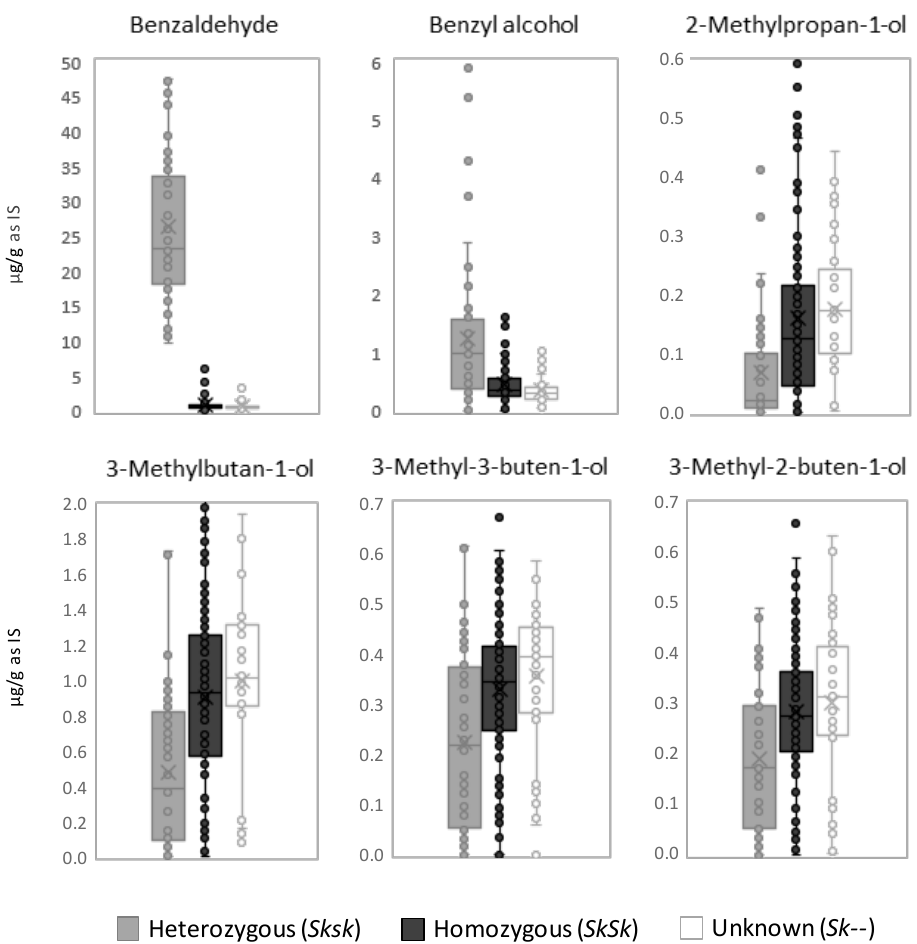
Figure 1. Box-and-whisker plots obtained for the selected variables in each group of sweet almond samples: heterozygous ( Sksk ), homozygous ( Sksk ) and samples with unknown ( Sk– ) genotype.